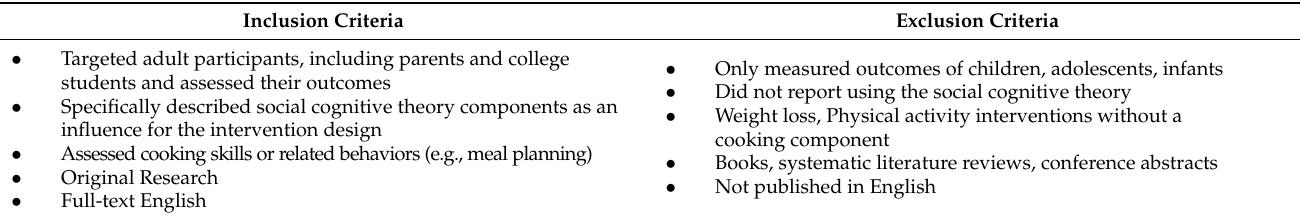
Table 1. Study criteria for inclusion or